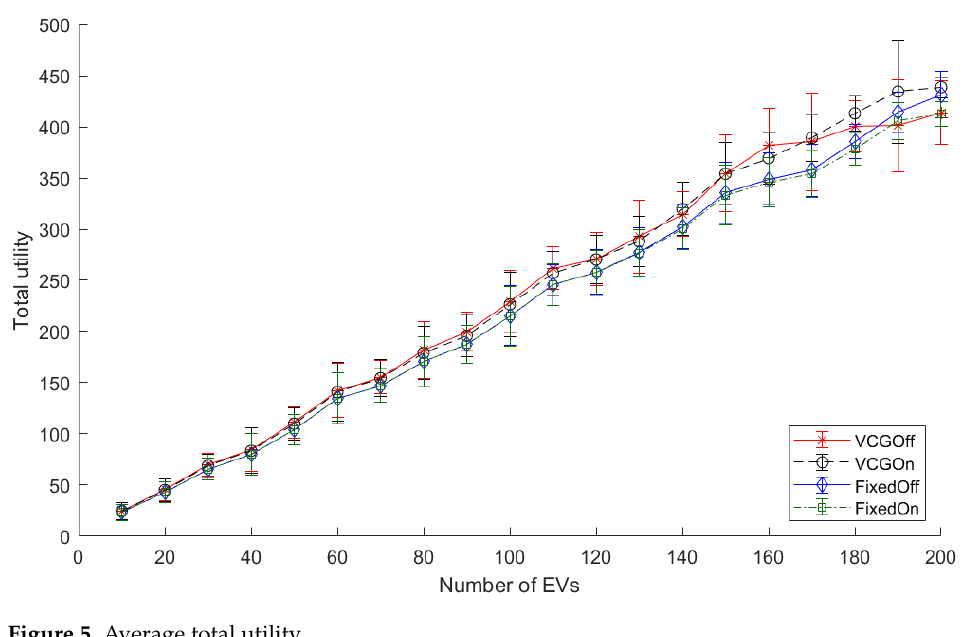
Figure 5. Average total utility.